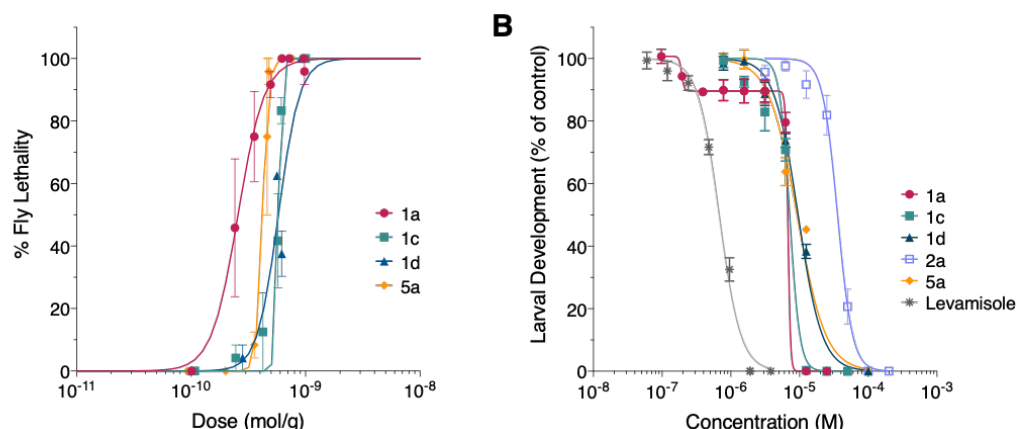
Figure 3. ( A ) Dose–response curves for insecticidal effects of Mp1a analogues 1a , c , d and 5a following microinjection into adult female fruit flies ( D. melanogaster ). ( B ) Concentration–response curves for anti-parasitic effects of Mp1a analogues against H. contortus . For both assays, data points represent the mean ± standard error of the mean (SEM) based on n = three experiments.